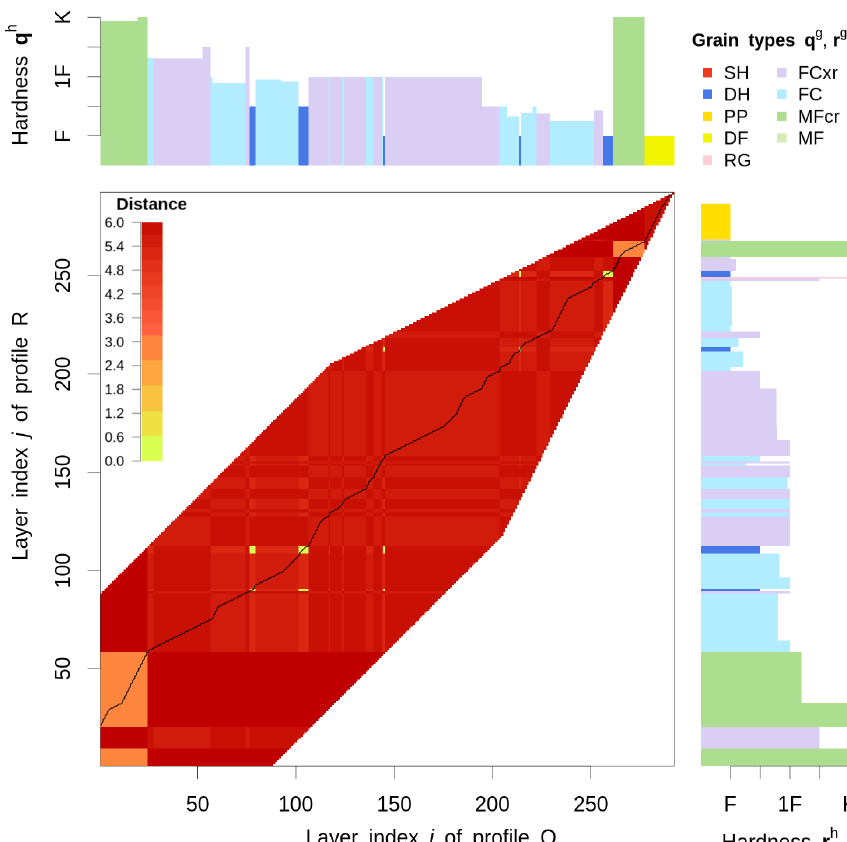
Figure 2. Visualization of a local cost matrix D , which stores the distance between individual layers of two snow profiles Q and R ; Q and R contain the layer characteristics of grain type q g and r g , as well as hardness q h and r h . D is only filled with values around its diagonal; the rest is clipped by a warping window and a local slope constraint. The back line represents the optimal warping path P , which accumulates the least cost while stepping through D and which defines the alignment of the two profiles; the preferential layer matching implementation becomes apparent in the yellow and orange cells, which represent smaller than average distances and will thus be matched more easily. See the text for further